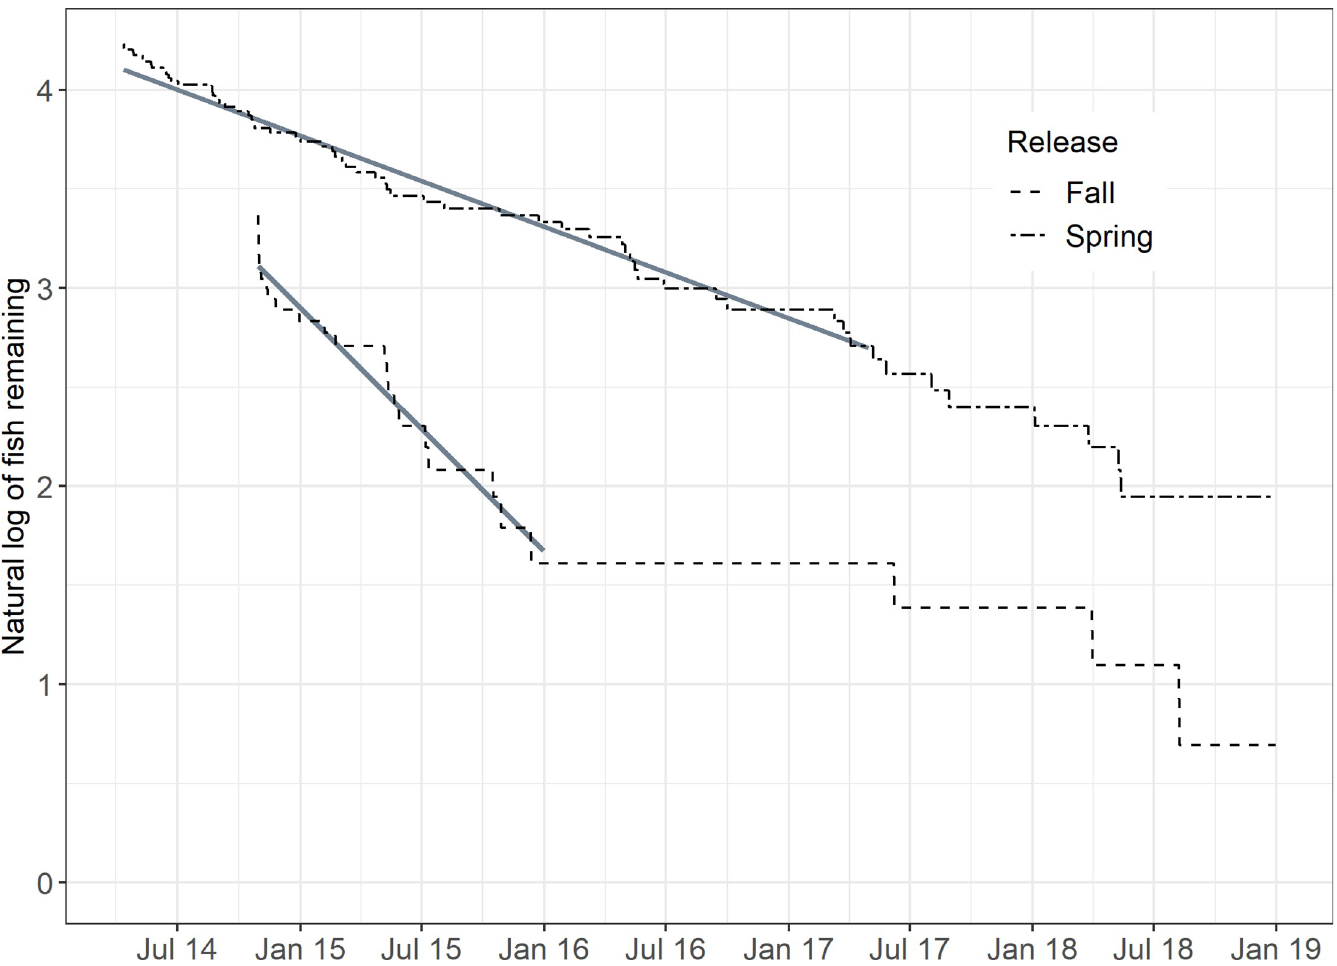
Fig 3. Attrition (log e n) of spring and fall released Potomac River striped bass. Fitted regression lines are overlain.